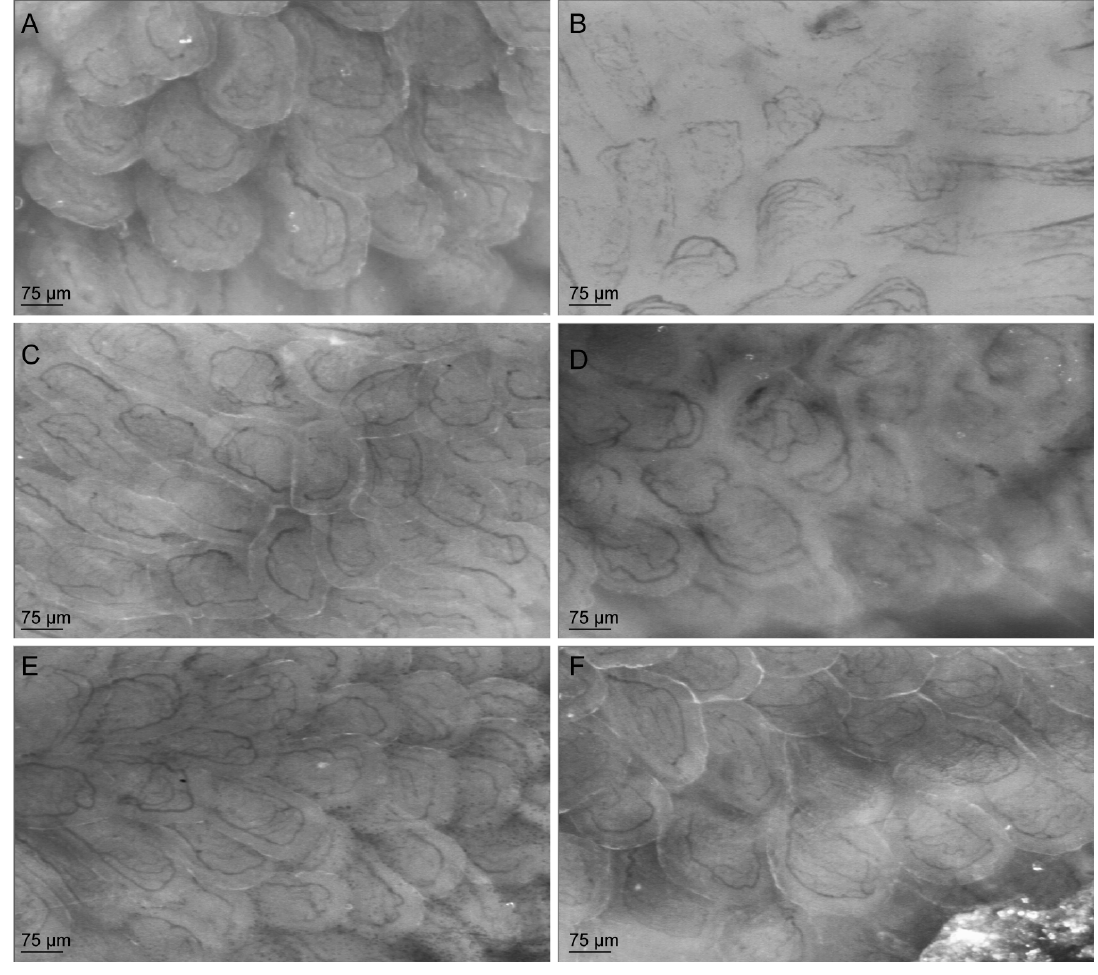
Figure 10. Representative live images of the microcirculatory measurements in jejunal villi with side stream dark-field (SDF)-imaging of control and arginase treated animals with or without L -citrulline or L -arginine supplementation. ( A ) Representative image of the jejunal microcirculation in a control mouse. ( B ) Representative image of an arginase-treated mouse, with a decreased number of perfused vessels per villus. ( C ) Representative image of the jejunal microcirculation in an L -arginine-treated mouse, which shows a comparable perfusion pattern as the control mouse. ( D ) Representative image of an arginase + L -arginine-treated mouse, which shows no beneficial effect of L -arginine supplementation on the perfusion. ( E ) Representative live image of an L -citrulline-treated mouse, which also shows a comparable perfusion pattern as the control and L -arginine-treated mouse. ( F ) Representative image of an arginase + L -citrulline-treated mouse, which shows more perfused vessels per villus compared to arginase and arginase + L -arginine-treated